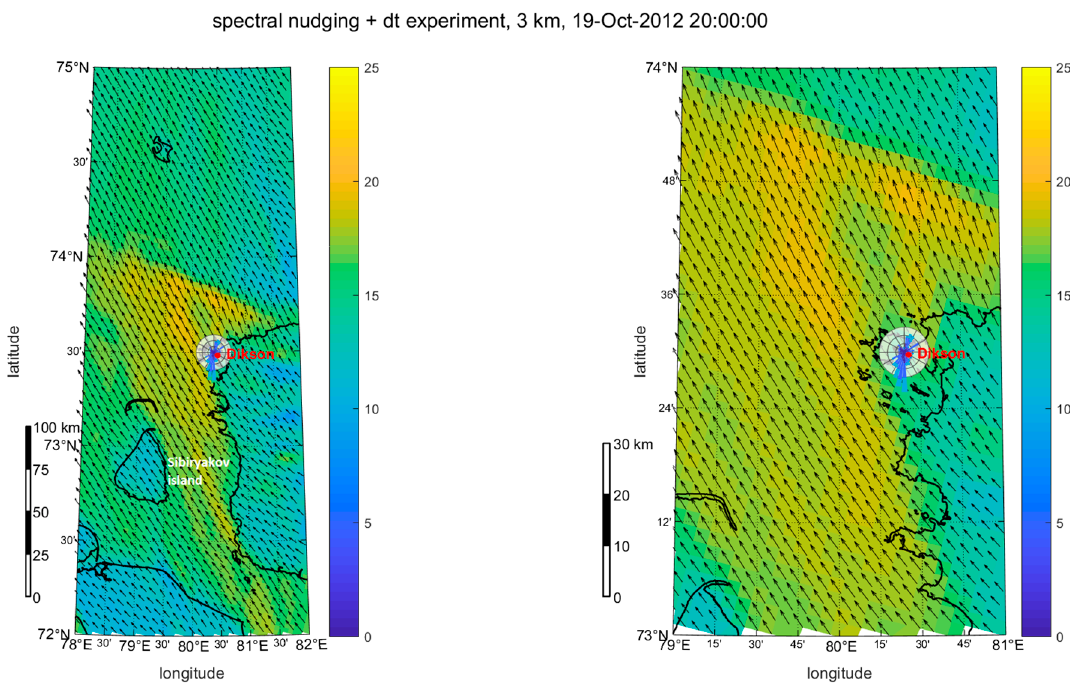
Figure 7. The same as in Figure 5, for the Dikson Island station region, 19 October 2012, at 20:00 GMT.